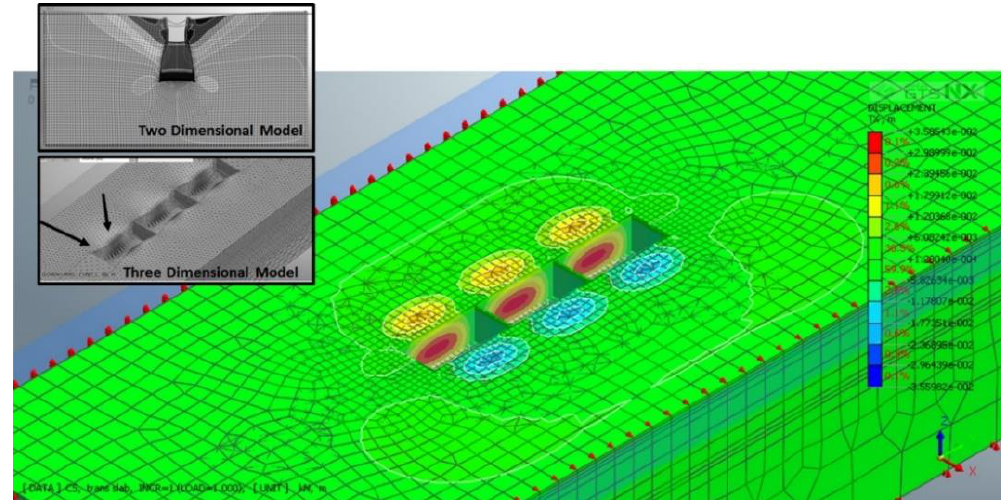
Figure 10. Deformed shape showing results of three-dimensional diaphragm walls ’ lateral deformation.